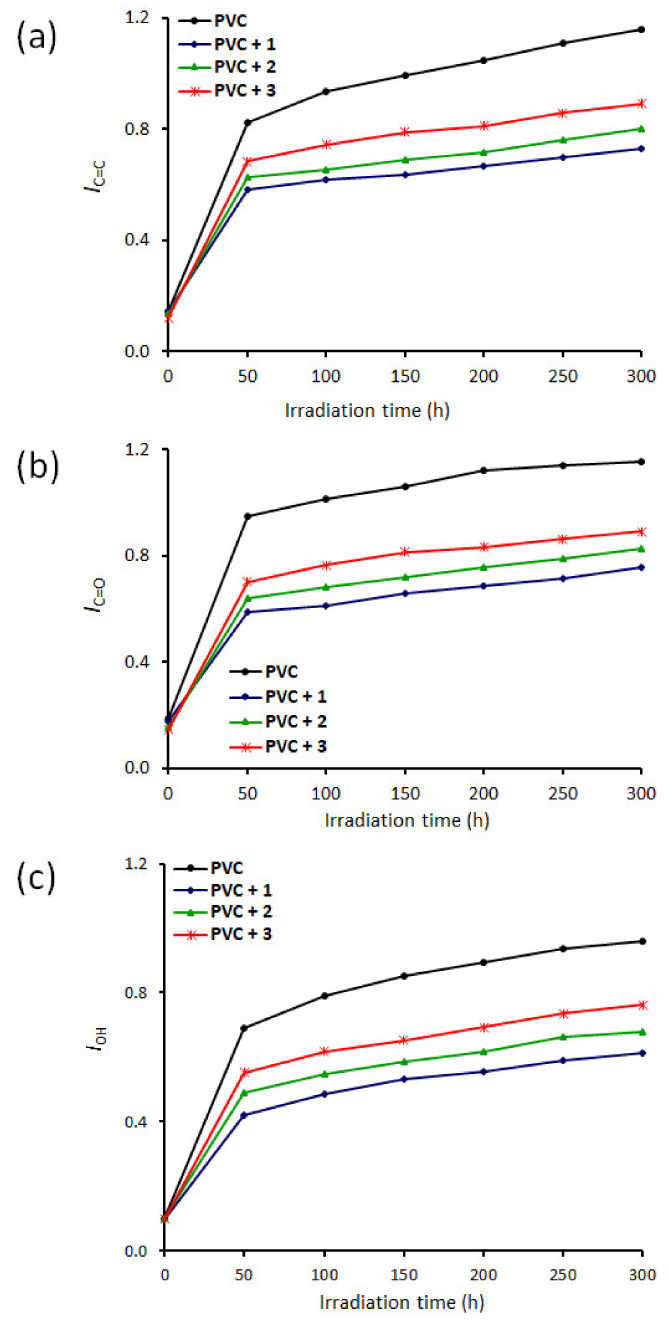
Figure 2. Effect of organosilanes 1 – 3 on the ( a ) I C = C , ( b ) I C = O and ( c ) I OH . For the I C = O , the change was lower for PVC films containing organosilanes 1 – 3 as compared with that for the blank film (Figure 2b). Again, organosilane 1 showed the most PVC-stabilizing effect. The I C = O values after 300 h of irradiation were 1.16, 0.76, 0.83 and 0.89 for the blank PVC film and those containing 1 , 2 and 3 , respectively. Similarly, the change in the I OH was higher for the blank PVC film as compared with the films containing organosilanes 1 – 3 (Figure 2c). After 300 h of irradiation, the I OH values were 0.96, 0.62, 0.68 and 0.76 for the PVC, PVC + 1 , PVC + 2 and PVC + 3 films, respectively. Clearly, monitoring and inspecting the FTIR spectra of irradiated PVC films indicated that organosilanes 1 – 3 acted as good PVC photostabilizers and inhibited the formation of by-product fragments that contained the C=C, C=O and OH